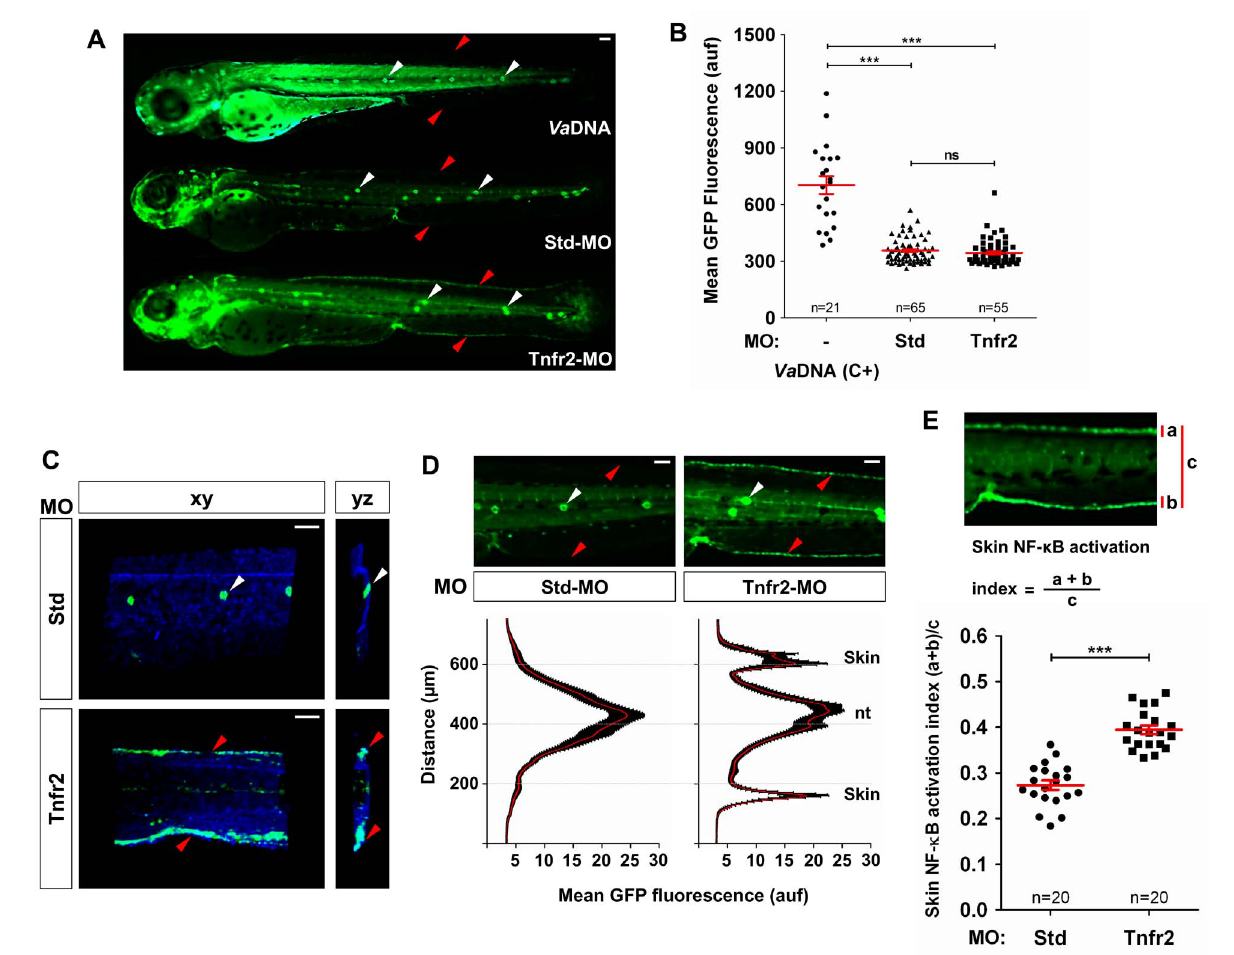
Figure 3. Tnfa and Tnfr2 deficiencies result in skin NF- k B activation. Zebrafish one-cell NF- k B:eGFP (A, B, D, E) or NF- k B:eGFP ; krt18:RFP (C) embryos were injected with standard control (Std) or Tnfr2 MOs alone or in the presence of 2.3 ng/egg of V. anguillarum genomic DNA (VaDNA), as a positive control for NF- k B activation. (A) Representative pictures showing the induction of NF- k B activation in the skin (red arrowheads) of Tnfr2- deficient larvae at 72 hpf and the ubiquitous, strong induction in their VaDNA-injected siblings. Note the strong expression of NF- k B in neuromasts of control larvae (white arrowheads). (B) The mean GFP fluorescence was quantified in whole larvae, and no significant differences between Tnfr2- morphants and control larvae were observed. Each dot represents the mean GFP fluorescence per single larva. The mean 6 S.E.M. of the whole GFP fluorescence for each group of larvae is also shown. (C) Representative frontal ( xy ) and lateral ( yz ) views of tridimensional reconstructions from confocal microscopy images of WIHC of NF- k B:eGFP ; krt18:RFP larvae stained at 3 dpf with anti-RFP antibodies (keratinocytes, blue) showing the induction of NF- k B in the skin (eGFP, green) of Tnfr2-deficient larvae. (D, E) Quantification of NF- k B activation in the skin of Tnfr2-deficient larvae at 72 hpf. (D) Fluorescence intensity was measured in the area indicated of wild-type and Tnfr2-deficient larvae, as explained in the legend to Figure 1 (15 larvae per treatment from 3 different experiments). The skin and the neuromasts have been labeled to facilitate the larval orientation. Note the activation of NF- k B in the skin of Tnfr2-deficient larvae. (E) The skin NF- k B activation index was defined as the fluorescence in the skin (a + b) relative to the total fluorescence of the whole larvae (c). Each dot represents the skin NF- k B activation index per single larva. The mean 6 S.E.M. of the skin NF- k B activation index for each group of larvae is also shown. Scale bars, 100 m m. ns, not significant; auf, arbitrary units of fluorescence. * p , 0.05; ** p , 0.01; *** p , 0.001.